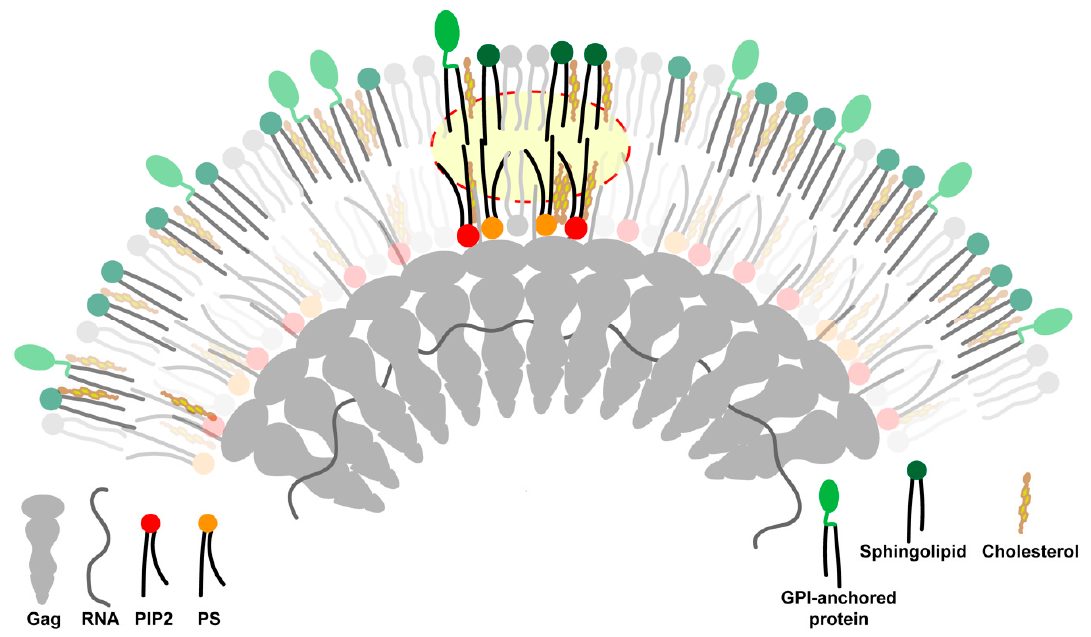
Figure 3. Transbilayer coupling model for viral assembly site phase separation. The oligomerizing Gag platform clusters and immobilizes inner leaflet acidic lipids, phosphatidylserine (PIP2), and phosphatidylserine (PS) at the viral assembly site. The ordering of the inner leaflet is transmitted to the outer leaflet via transbilayer interactions. The long, saturated acyl chains at the sn1-position of the acidic lipids can physically interact with the long, saturated acyl chains of outer leaflet lipids and lipid-anchored proteins (highlighted by the yellow backdrop). The resulting transbilayer coupling leads to the recruitment of outer leaflet sphingolipids and glycosyl phosphatidylinositol (GPI)-anchored proteins to the viral assembly site. The clustering of lipids and lipid-anchored proteins in both leaflets of the assembly site decreases the entropy of the mixing of assembly site lipids. This eventually triggers the phase separation of the viral assembly site from the surrounding bulk plasma membrane. The Figure is not drawn to scale.